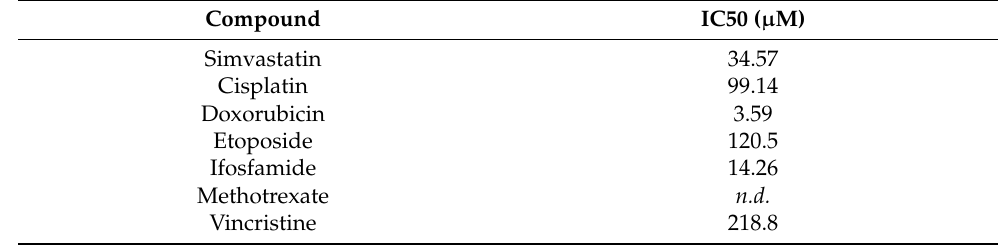
Table 2. IC 50 values of drugs in the murine K7M2 cell line, as assessed by the MTT test after 24 h of exposure. n.d. not